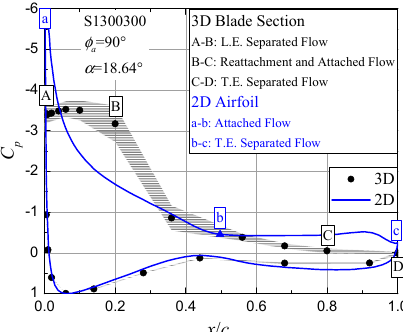
Figure 16. Pressure distributions of the 3D blade section and 2D airfoil at ϕ a = 90°. r / R = 30%, V w = 13 m/s, and ϕ y = 30°.